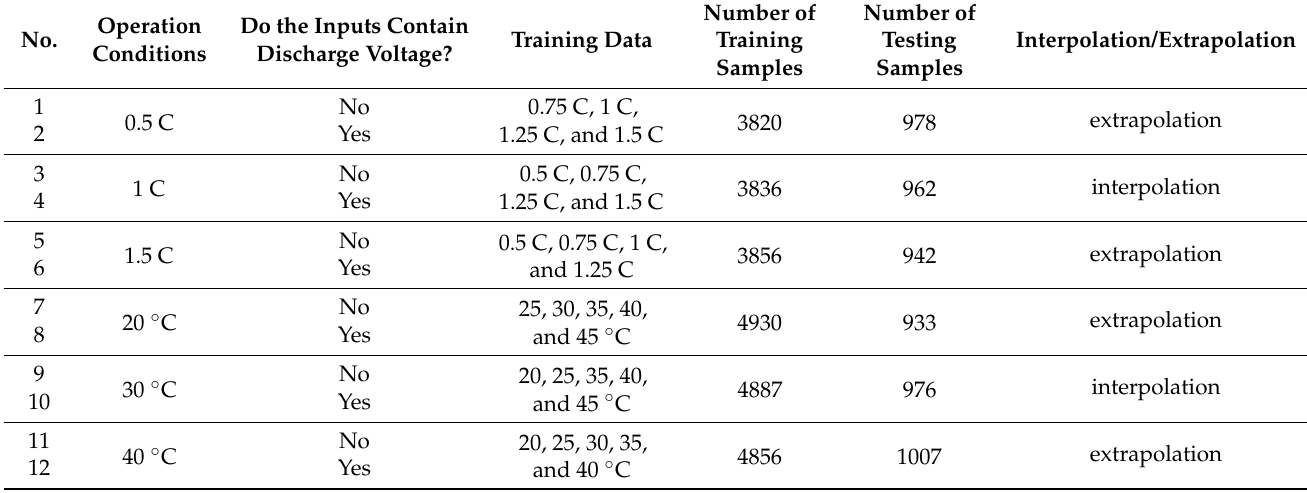
Table 1. Operating conditions to be predicted and the data